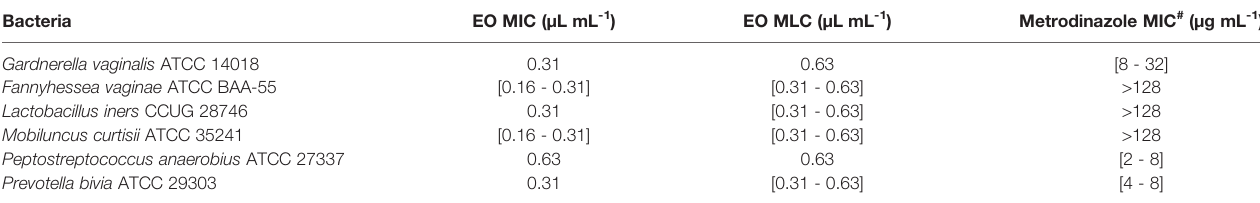
TABLE 2 | Determination of the minimum inhibitory (MIC) and minimum lethal (MLC) concentrations of Thymbra capitata essential oil against BV-associated species and comparison with standard antibiotics.